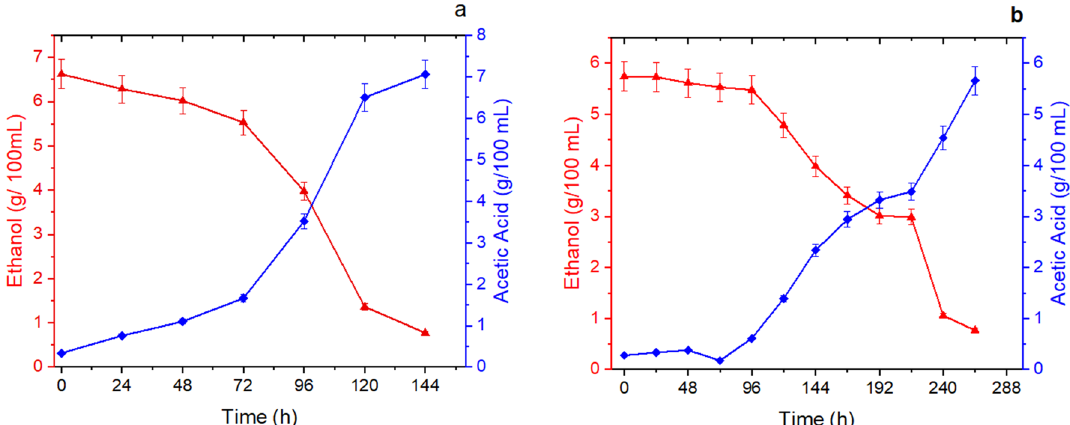
Figure 4. Ethanol to acetic acid bioconversion kinetic profile in the acetification of pineapple ( a ) pulp and ( b ) peel wines. Ethanol (red filled uptriangle) and acetic acid (blue filled diamond)